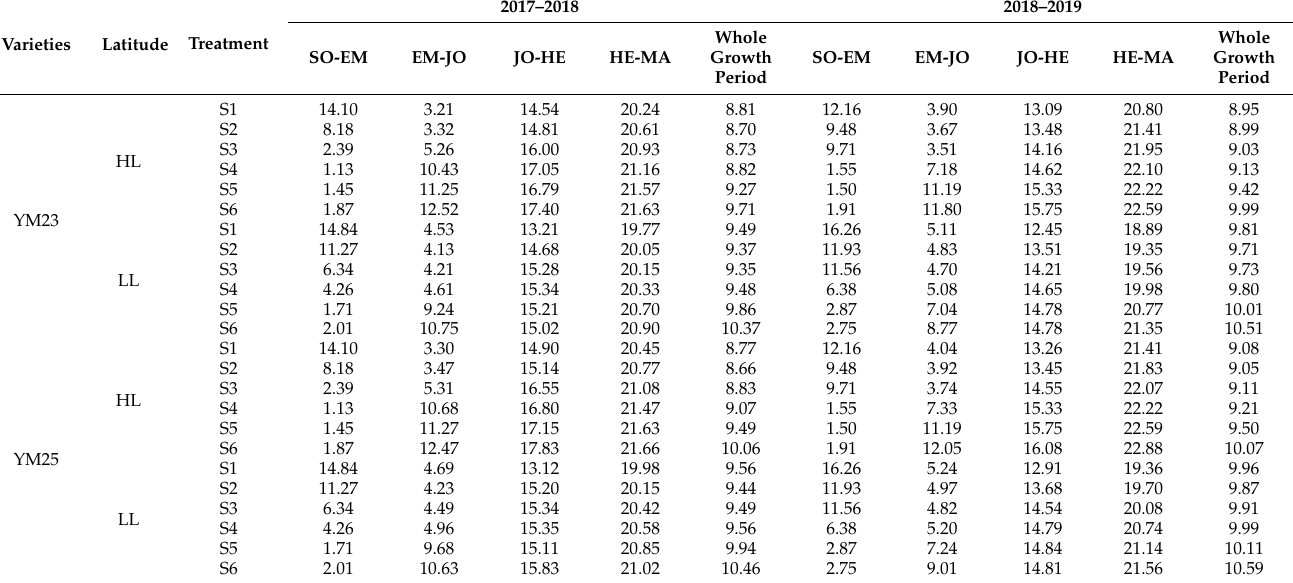
Table 2. Difference in mean daily temperature at different latitudes and sowing dates ( ◦